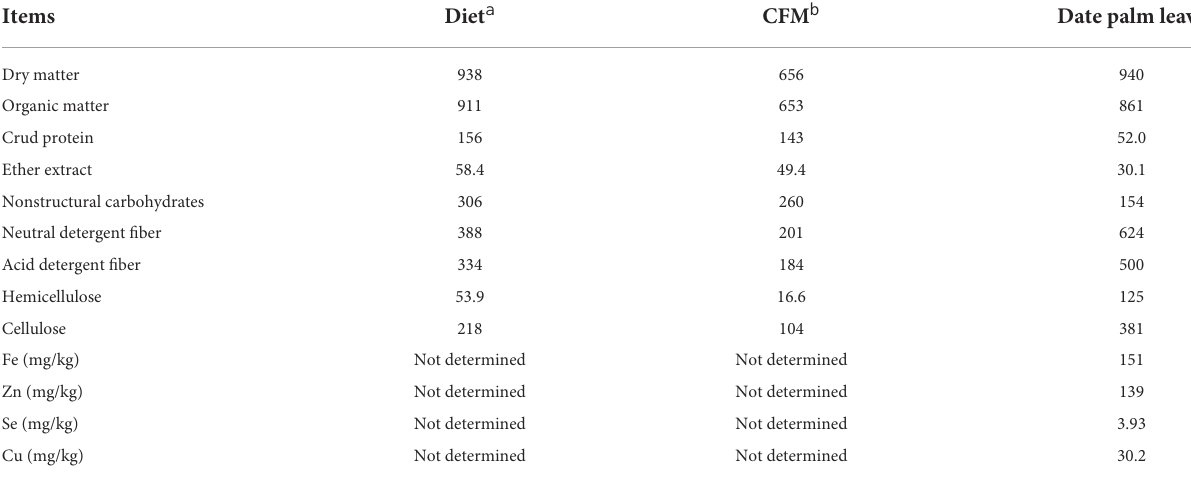
TABLE 1 Chemical composition (g/kg DM) of date palm leaves, the concentrate feed mixture and basal diet used in experiment 1 and 2.